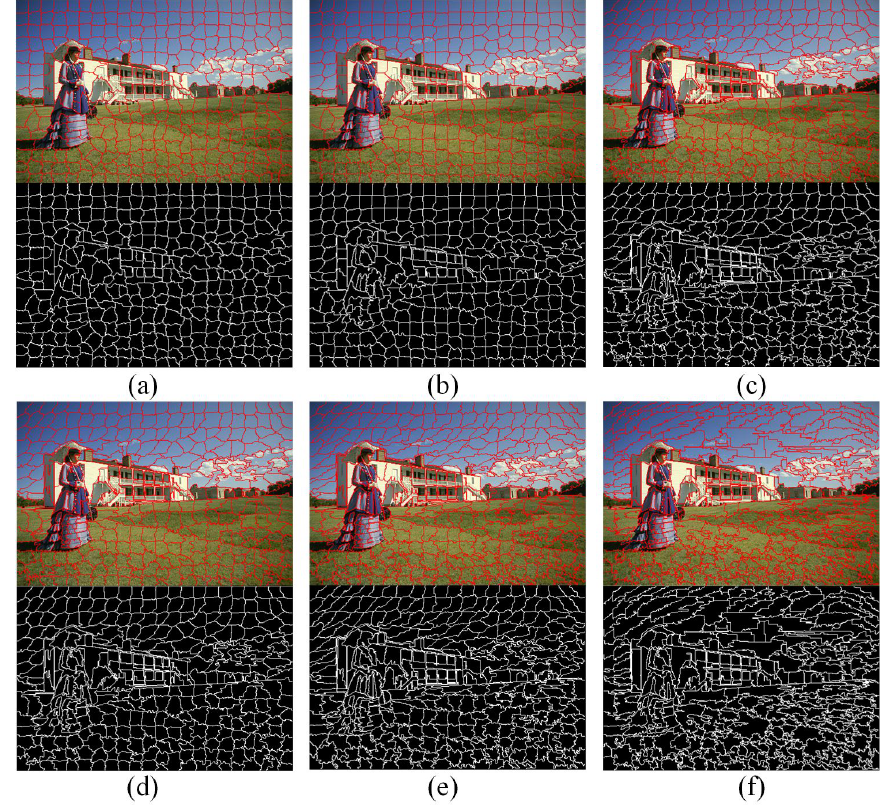
Figure 11. Typical visual results show the impact of different energy terms in the energy function. ( a ) is a shape regularization term only ( λ color = 0, λ dist = 1, λ smooth = 0 ) ; ( b )